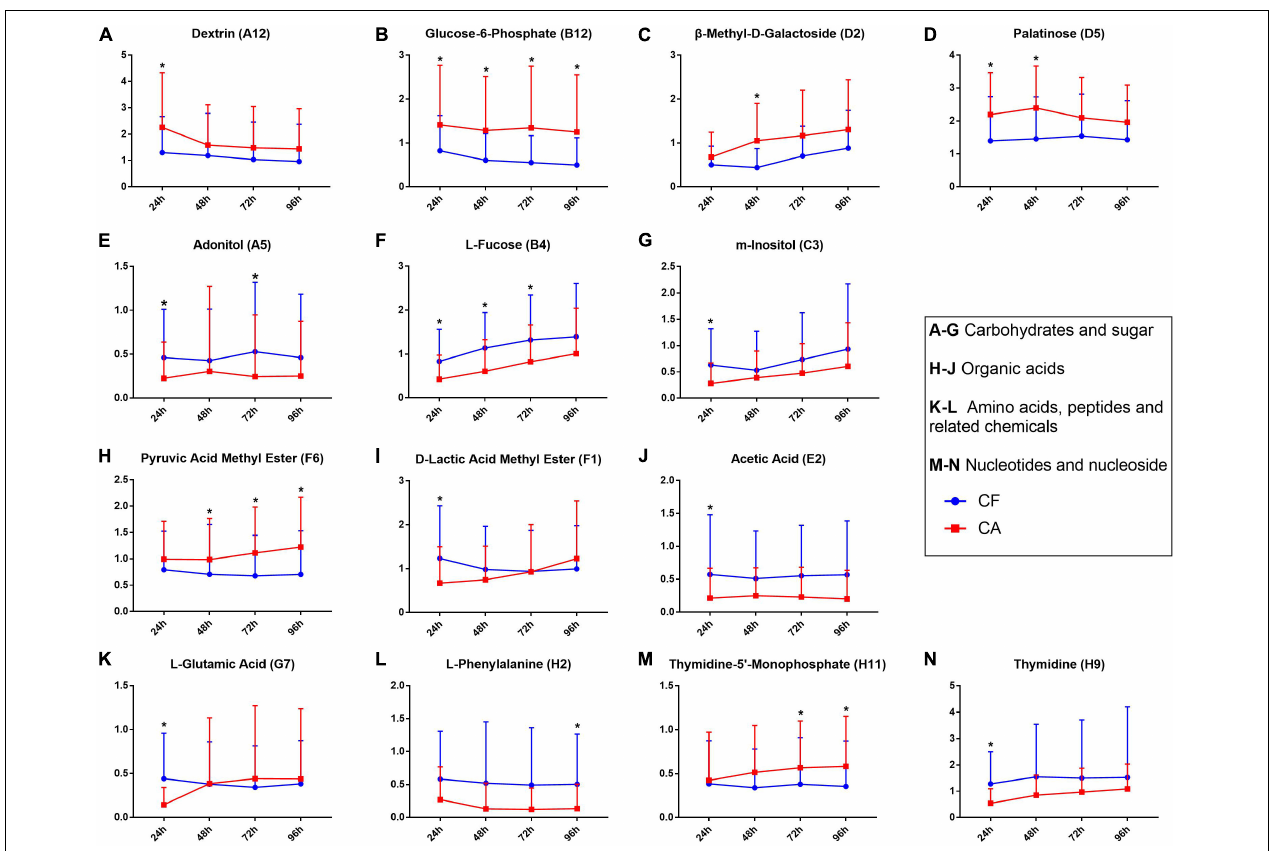
FIGURE 3 | Carbon sources significantly differentially utilized between CF and CA groups. (A–G) were carbohydrates and sugar, (H–J) were organic acids, (K,L) were amino acids, peptides and related chemicals, (M,N) were nucleotides and nucleoside. Blue line represents CF group, red line represents CA group. All the y -axis represents transformed data, mean values ± SD were shown, Mann-Whitney U -test was used for statistical analysis, an asterisk ( ∗ ) indicates a significant difference between the two values ( P <